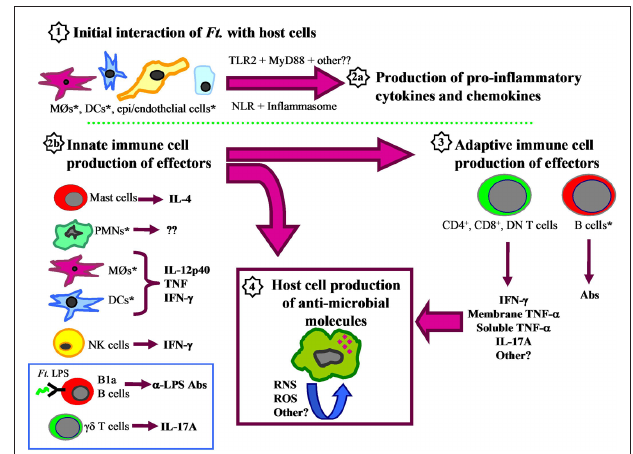
FIguRE 1 | Components of murine innate and adaptive immune responses to Francisella . (1) The initial interaction of Francisella with host cells, such as macrophages, dendritic cells, epithelial cells, and endothelial cells, stimulates production of pro-inflammatory cytokines and